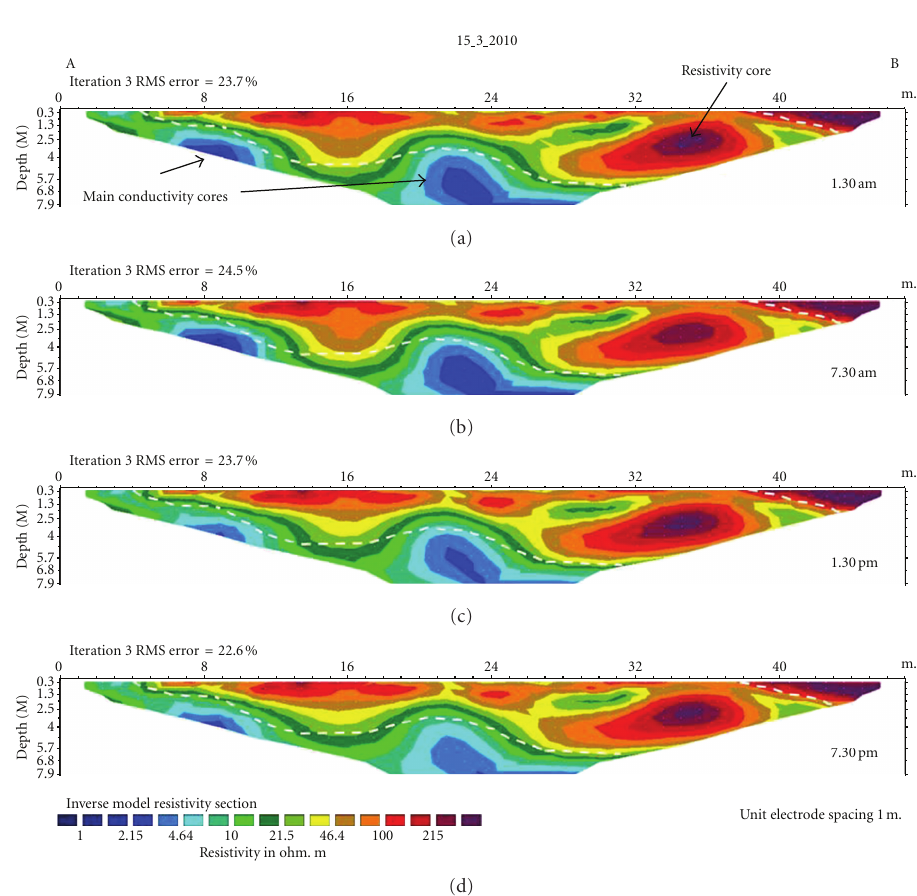
Figure 7: ERT related to the 15/03/2010 daily cycle of